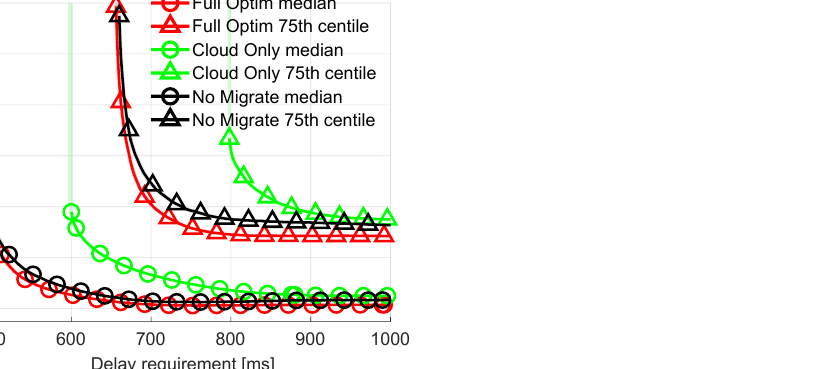
Figure 6. Comparison of energy consumption per request with varied delay requirement of